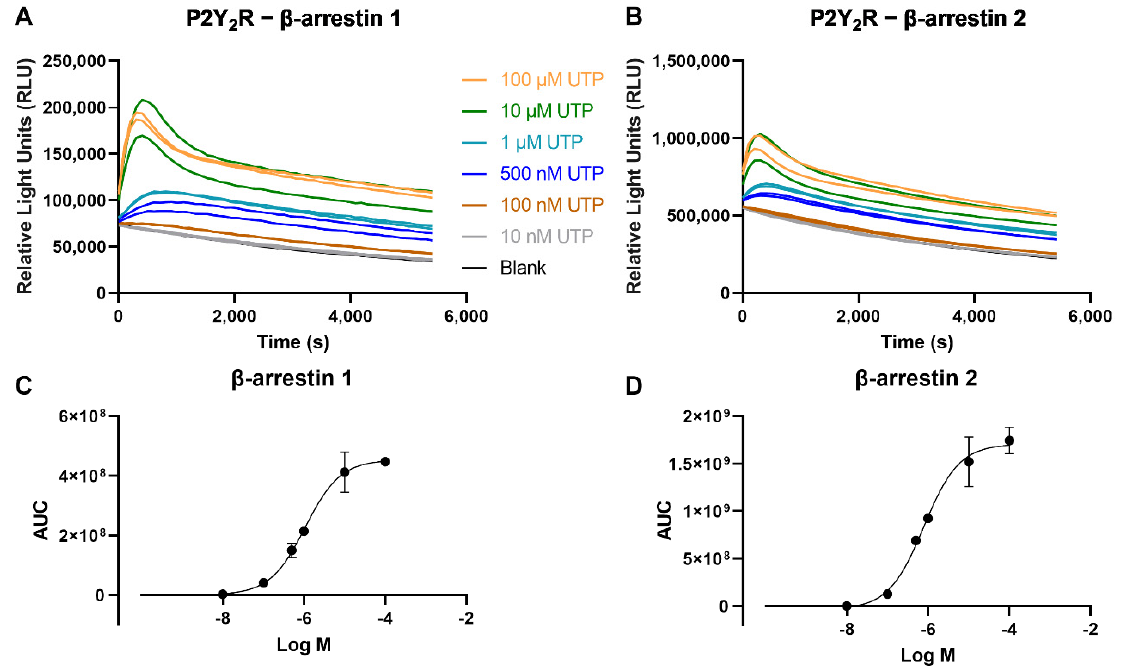
Figure 3. Time-luminescence curves of a concentration range of the reference agonist UTP in the NanoBiT ® system, monitoring the recruitment of ( A ) β arr1, or ( B ) β arr2 to the P2Y 2 R. Data shown are of one representative experiment out of three independent experiments, of which each condition was performed in duplicate. Panels ( C , D ) depict the corresponding sigmoidal concentration-response curves, with data points represented as mean ± SEM (standard error of the mean).